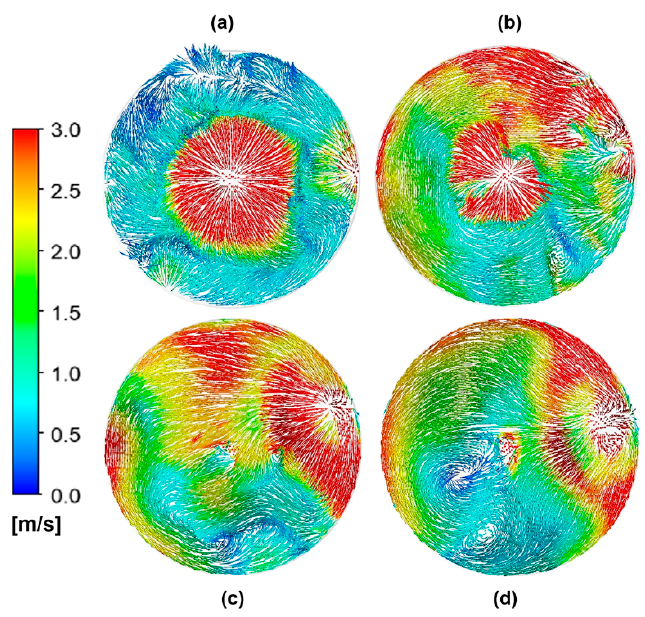
Figure 14. Velocity fields in a horizontal plane located 0.10 m from the bath surface at different bath levels: ( a ) 16 tons, ( b ) 30 tons, ( c ) 50 tons and ( d ) 80 tons.